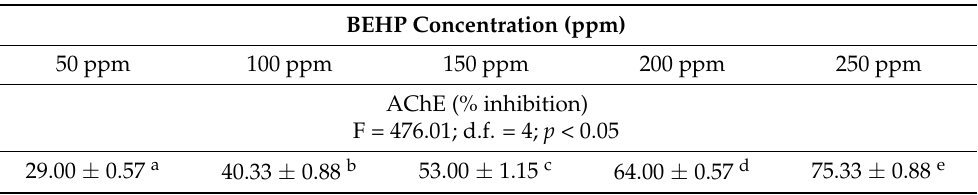
Table 4. Effect of different BEHP concentrations on percent inhibition of acetylcholinesterase (AChE) activity in C. quinquefascitus larvae after 72 h.